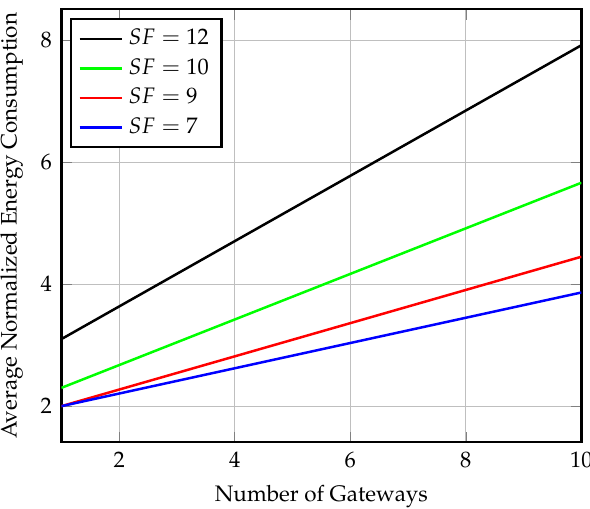
Figure 16. Average energy consumption at the end-node for different SF values and multiple gateways at speed = 80 km/h and R on = 8 windows/h for nonsynchronized gateway arrival